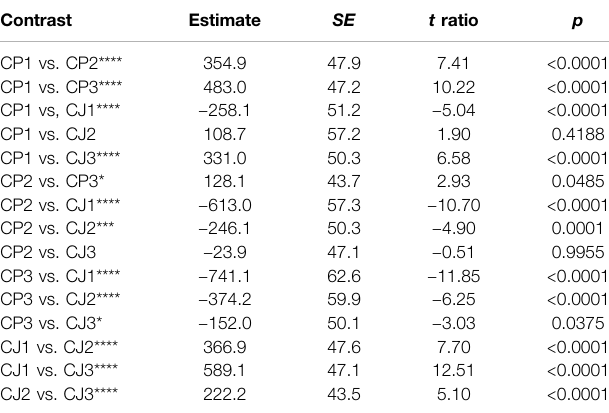
TABLE 6 | All the contrasts of the response times of correct answers of Chinese word and picture pairs (CP) and Chinese word and Japanese word pairs (CJ) in recognition